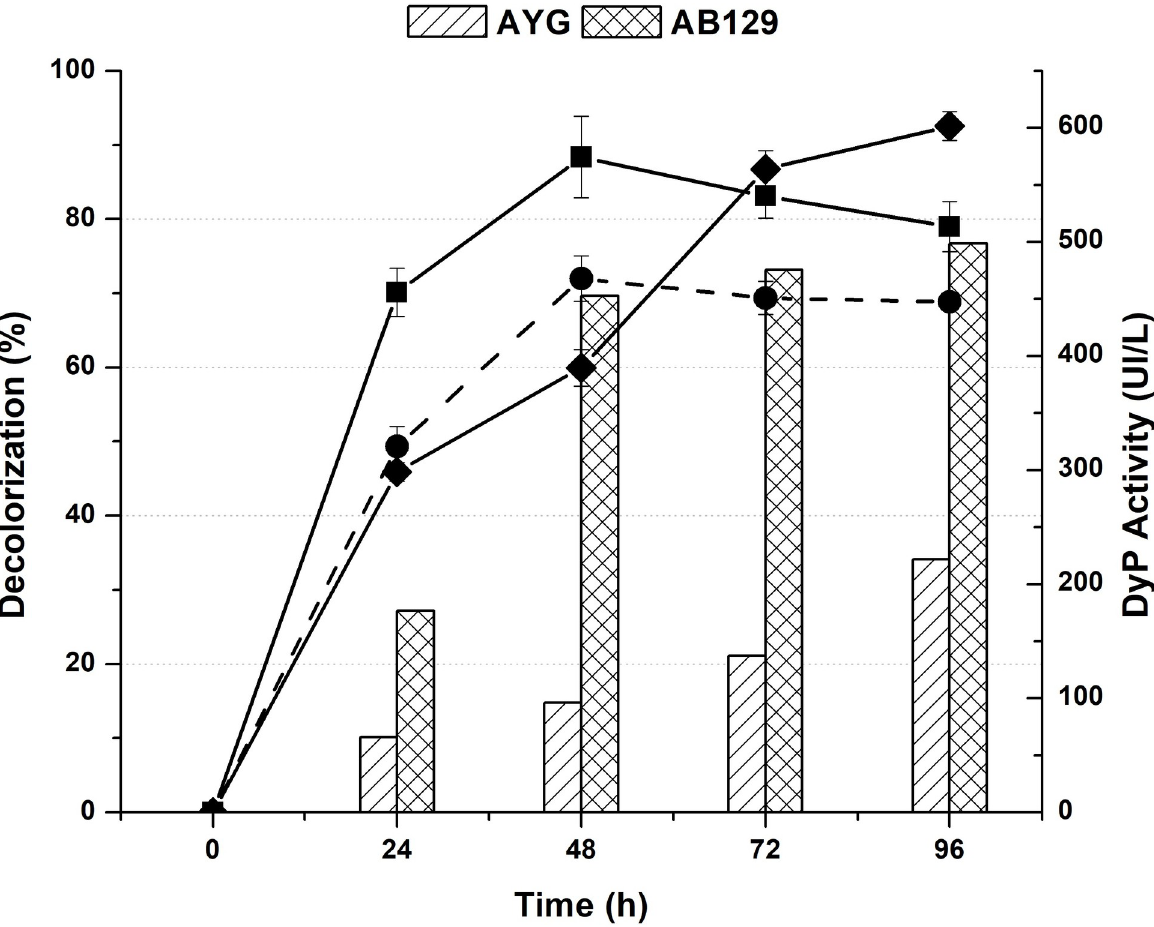
Fig 5. Time course of recombinant DyP activity and percentage dye decolorization. The evolution of the extracellular DyP activity and percentage dye decolorization during the liquid cultures of the T . atroviride TaDyP1_7 transformant was determined in both PDB medium and PDB containing either the AYG or AB129 dyes. DyP activity (broken line) in PDB (•black circle), AYG ( ■ black square) and AB129 ( ♦ black diamond). Data points represent the mean of three independent replicates, while the standard error of the mean (SE) is indicated by error